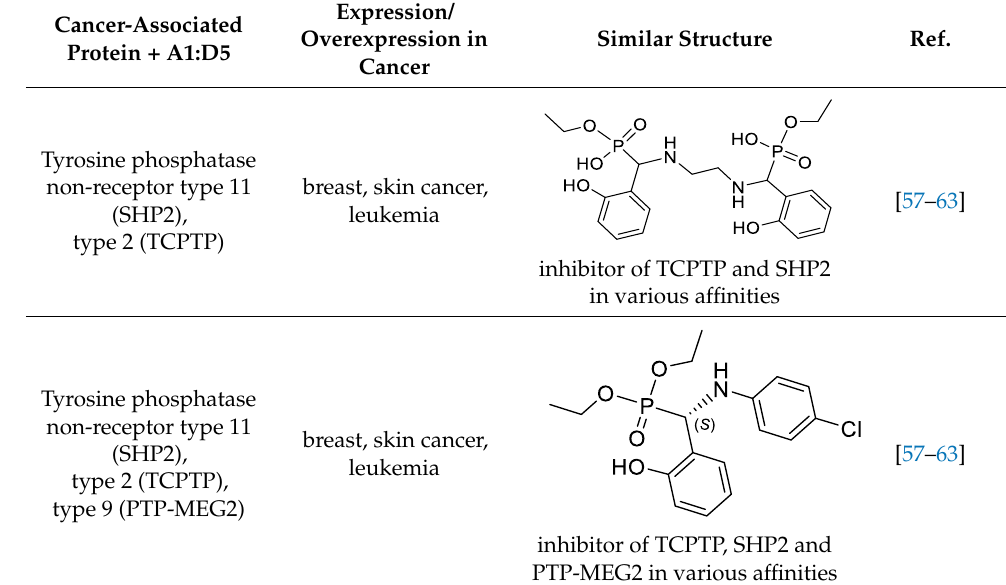
Similar Structure